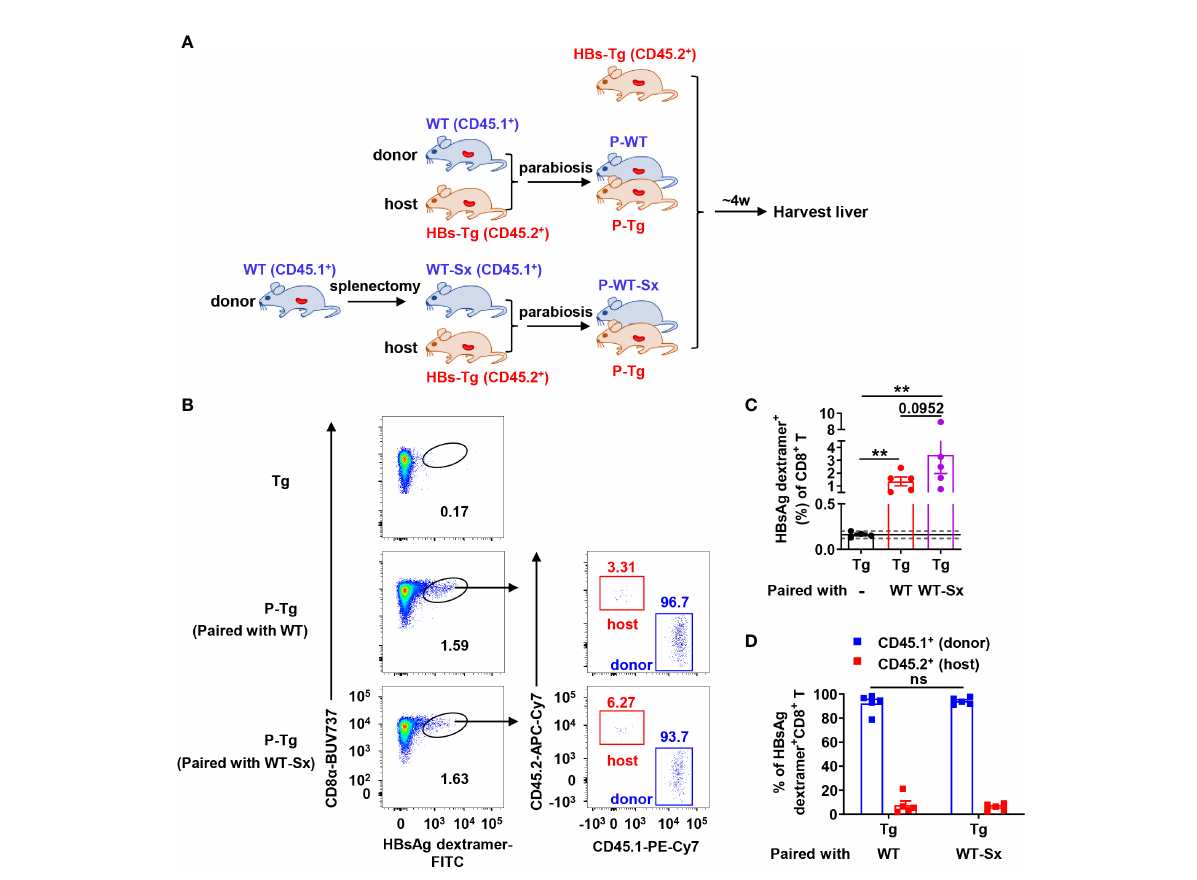
FIGURE 4 Donor HBsAg-speci fi c CD8 + T cells could be generated in the HBs-Tg parabionts paired with splenectomized-WT mice. WT mice (CD45.1 + ) were performed splenectomy and were then surgically conjoined with HBs-Tg (CD45.2 + ) mice to generate WT-Sx-HBs-Tg parabiotic mice. Four weeks after parabiosis surgery, parabiotic mice were separated and liver samples were harvested from each group. Intrahepatic MNCs were isolated for fl ow cytometry analysis. (A) Protocol for the model of WT-Sx-HBs-Tg parabiotic mice and WT-HBs-Tg parabiotic mice (schematic). (B) Representative plots showing the frequency of HBsAg dextramer + CD8 + T cells in the liver of parabiotic and control HBs-Tg mice. (C) The frequency of HBsAg dextramer + CD8 + T cells in the liver of P-Tg (paired with WT-Sx), compared with P-Tg (paired with WT) and Tg (HBs-Tg control without parabiosis). The data ranging in 95% con fi dence interval (CI) (0.16% ± 0.04%, as described in Figure 3B) were considered negative. A Fisher ’ s exact test was used to compare the positive rate of MHC dextramer staining in P-Tg (paired with WT) and P-Tg (paired with WT-Sx) groups with Tg group respectively. The Mann-Whitney test was used to compare the frequency of HBsAg dextramer + CD8 + T cells between P-Tg (paired with WT) and P-Tg (paired with WT-Sx) groups. (D) The proportion of CD45.1 + (donor) or CD45.2 + (host) in HBsAg dextramer + CD8 + T cells from the liver of P-Tg (paired with WT-Sx), compared with P-Tg (paired with WT). Two-way ANOVA with Sidak ’ s multiple comparison test was used. Data are shown as mean ± SEM. The number between the bar show the p-value. ** P < 0.01; ns, not signi fi cant. Tg, HBs-Tg control; P-WT, WT parabiont; P-Tg, HBs-Tg parabiont; Sx,